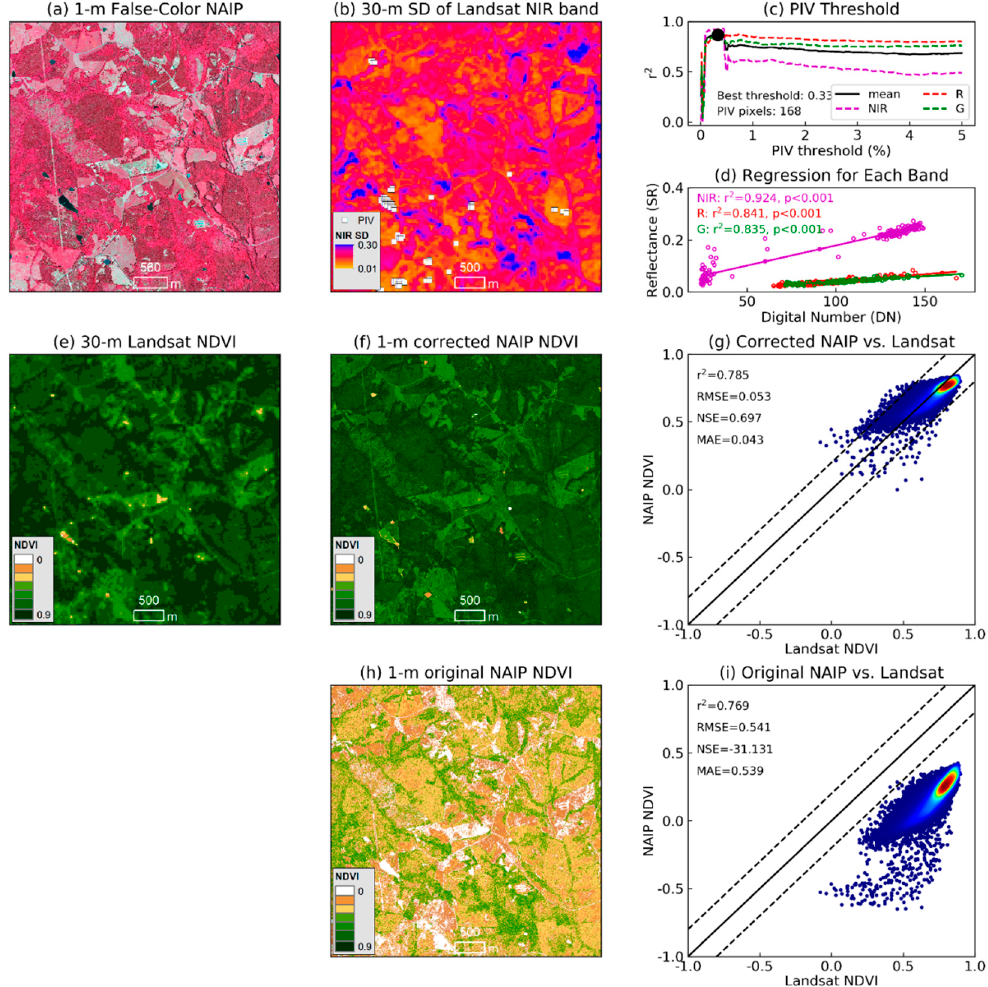
Figure 6. Application of PINT at site 3. Plots ( a )–( d ) demonstrate the identification of pseudoinvariant (PIV) pixels: plot ( a ) shows the 1 m false-color National Agriculture Imagery Program (NAIP) image (near-infrared (NIR), red and green bands) before radiometric correction; plot ( b ) shows pseudoinvariant features (white squares) identified from the 10 year NIR standard deviation of Landsat TM and ETM+ images; plot ( c ) demonstrates the identification of the best threshold (0.01st percentile); and plot ( d ) shows the linear regressions of Landsat surface reflectance and NAIP digital numbers based on pseudoinvariant pixels. Plots ( e )–( i ) show the validation of the normalized difference vegetation index (NDVI) values: plot ( e ) shows 30 m Landsat NDVI as the reference; plots ( f ) and ( h ) show 1 m NAIP NDVI before and after correction, respectively; and plots ( g ) and ( i ) show the agreement with Landsat reference before and after correction, respectively. The solid line is the 1:1 line, indicating a perfect match between NAIP and Landsat NDVI values, and the dashed lines represent the upper and lower 10% error bounds.